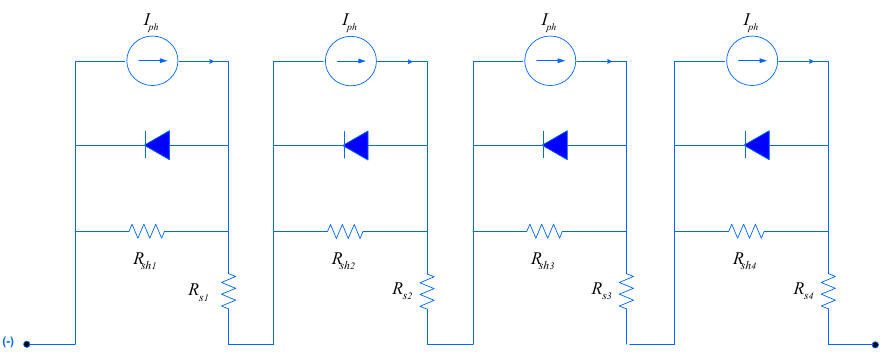
Figure 6. Equivalent circuit of photovoltaic panels.